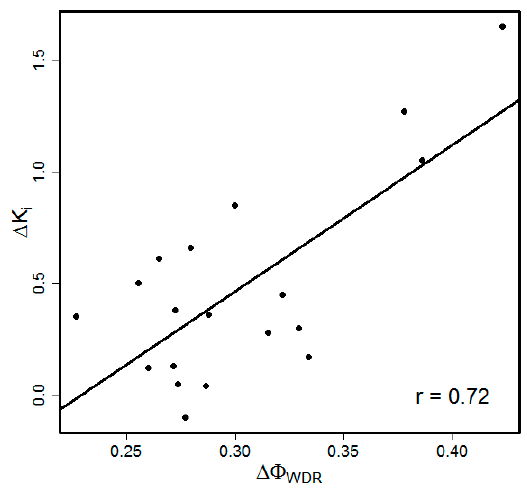
Figure 1. Correlation between the scores produced by the ∆Φ WDR model and experimental kinetic data for inhibition of PjDHFR variants by TMP. K i values are log 10 transformed and converted to a change relative to inhibition kinetics of the reference PjDHFR.